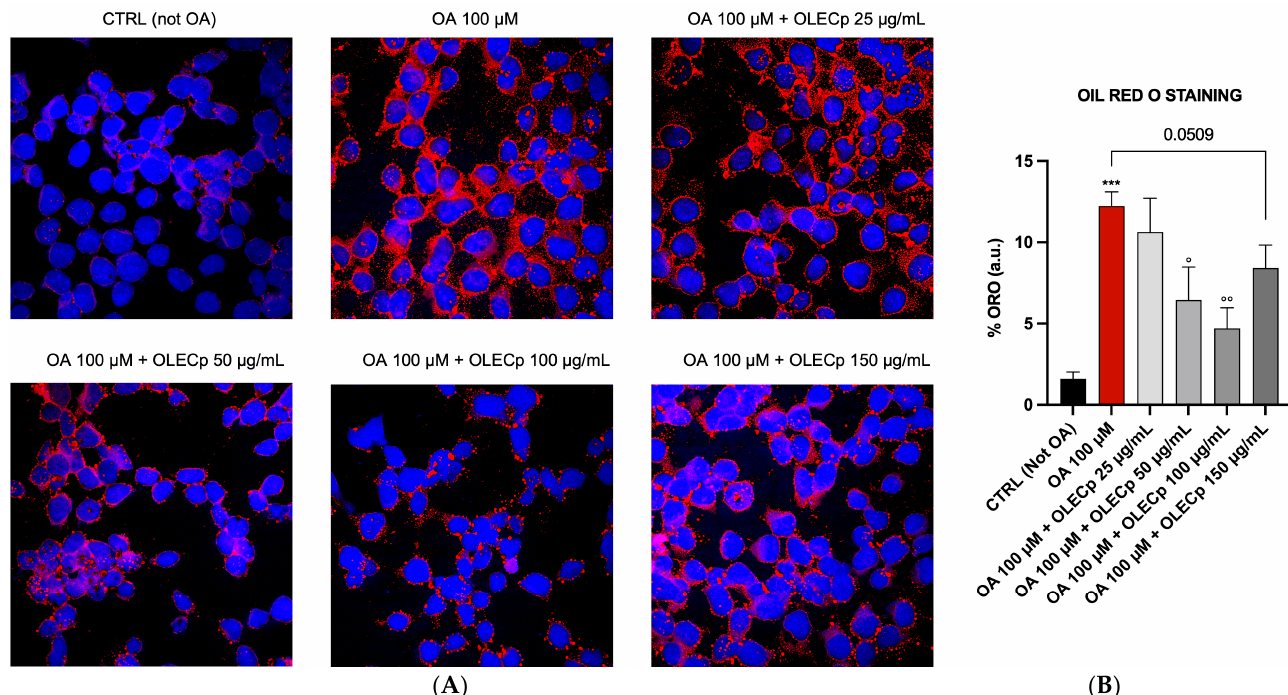
Figure 9. Totally fatty acid accumulation assessed by Oil Red O (ORO) Staining. ( A ) Representative ORO-DAPI merged confocal fluorescent images of intracellular lipid accumulation in McA-RH7777. ( B ) The results are expressed as mean ± S.E.M.; ***: p < 0.001 vs. CTRL; ◦ : p < 0.05, ◦◦ : p < 0.01 vs. OA 100 μ M.